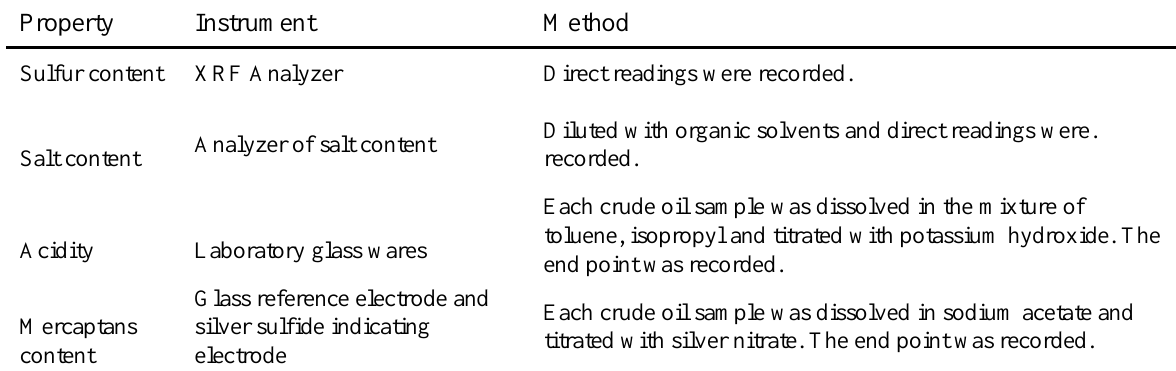
Table 1. Corrosive aided properties of crude oils and their testing